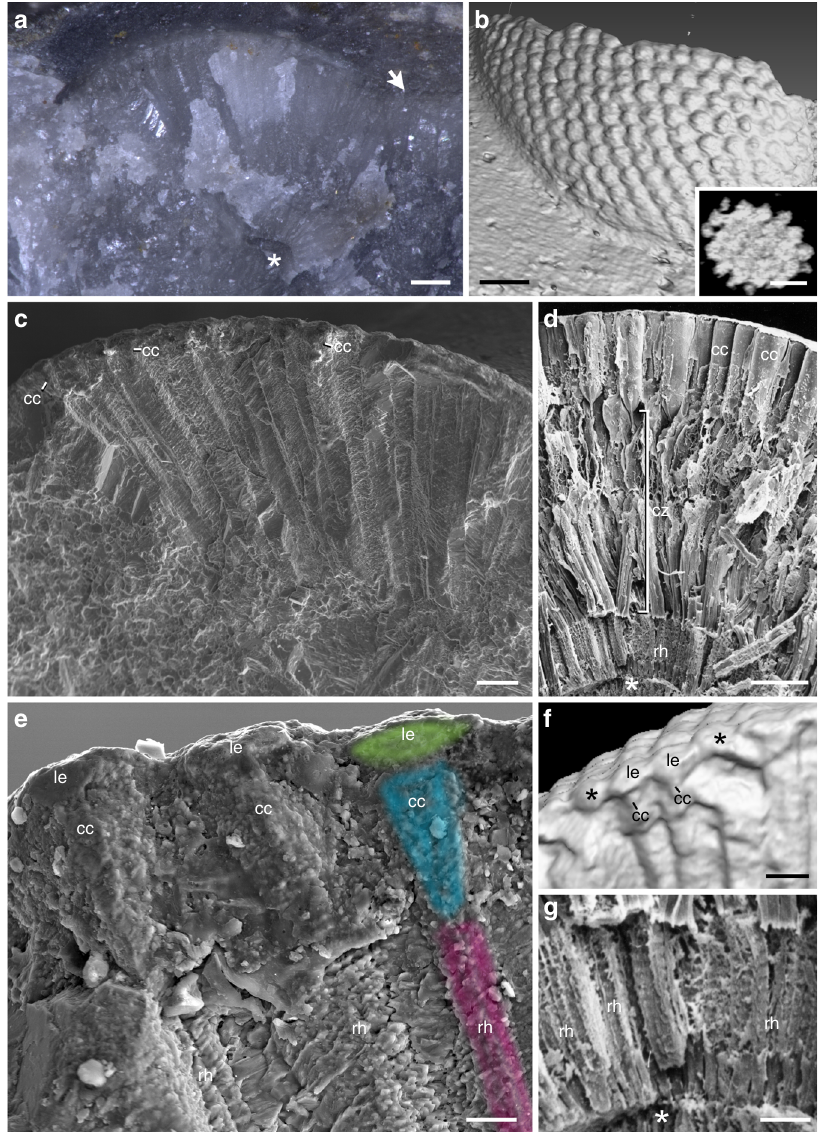
Fig. 3 The compound eye of Archegonus warsteinensis compared with a Recent crustacean eye. Microphotograph ( a ), μ -CT scan ( b, f ), SEM ( c – e, g ). a Inner perspective of the eye of A. warsteinensis with the regular arrangement of calcite underneath the cuticular facets. Arrow marks the transition between the eye and body, the cuticle thickens and the calcite shows no regular pattern. Asterisk marks conserved part of the compound eye ’ s basal membrane. b Surface rendering showing the hexagonal facets. Inset: Section tangential to the eye ’ s surface revealing the separate putative optical units. c Similar perspective as in ( a ). The regular pattern of the internal eye parts is visible. Each elongate structure underneath a facet is subdivided into distinct elements, which putatively represent ommatidia. d For comparison, the fracture of an eye of the crustacean Meganyctiphanes norvegica displaying the ommatidial structure: crystalline cones and retinula cells with layered rhabdoms (lenses removed) (after ref. 4 , with permission of the author). Between the crystalline cones and the rhabdom there is a clear zone characteristic of refractive superposition eyes 4 . Asterisk marks the compound eye ’ s basal membrane (compare with a ). e Enlarged part of ( c ) depicting the details of three putative ommatidia of the fossil trilobite eye. The biconvex lenses (light green) are combined with cone-shaped crystalline cones (turquoise) and adjacent elongate rhabdoms (magenta) resembling those of modern euarthropods (compare with f , g , and Fig. 1b). f Surface rendering of the lens - crystalline cone complex of another part of the eye of A. warsteinensis . The asterisks mark two lenses lacking crystalline cones showing the biconvex form of the lenses and indicating that cones and lenses are separate structures. g The rhabdom of M. norvegica (enlarged from d ) revealing a corresponding structure to that of A. warsteinensis (after ref. 4 , with permission of the author). Asterisk marks the basal membrane of the eye. Scale bars 200 μ m ( a ), 150 μ m ( b ), 100 μ m ( b inset, c ), 50 μ m ( d , f ), 20 μ m ( e ), and 10 μ m ( g ). cc, crystalline cones; cz,